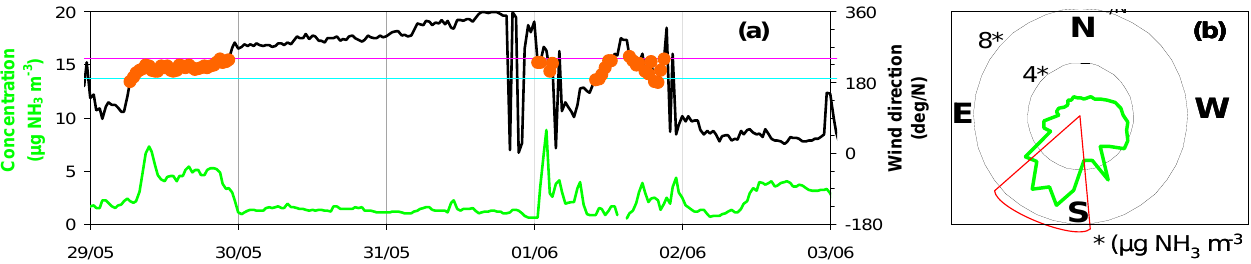
Fig. 7. (a) Example period when the NH 3 concentration was enhanced when the wind was blowing from the farm. The purple and Cyan lines show the wind sector where the wind was blowing from the farm. (b) Ammonia concentration rose averaged over the whole period. The wind sector where the wind is blowing from the farm is materialised by the red triangle.